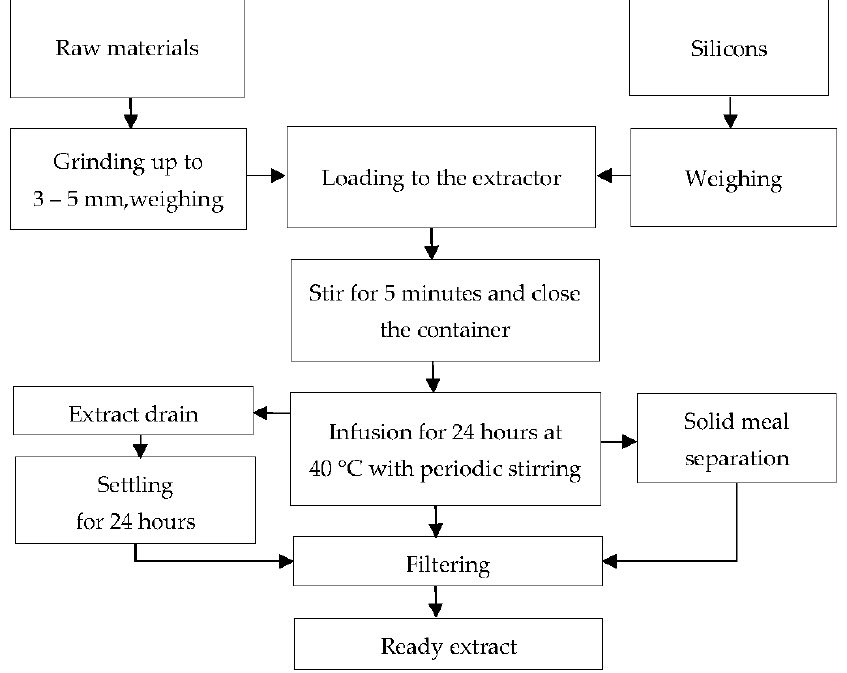
Figure 1. Technological scheme of vegetable raw material extraction silicone